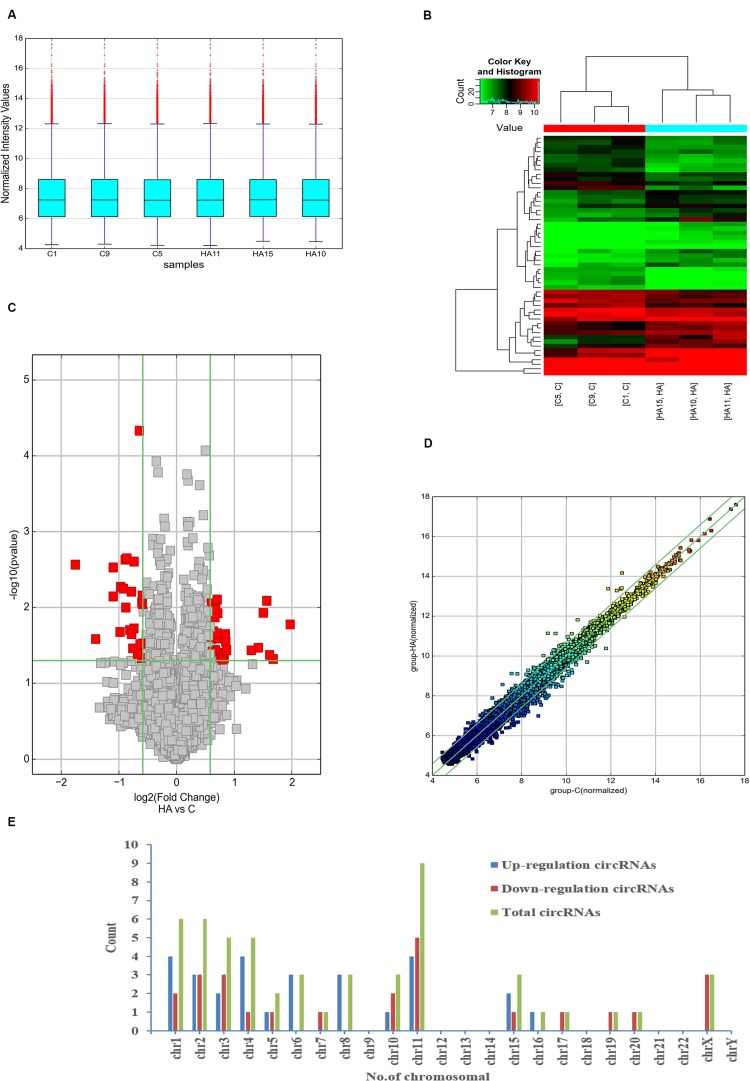
Differential expression of circRNAs in rat hypothalamus. (A) Box plot showing the distribution of circRNA expression values in the HA and C groups. (B) Hierarchical clustering of circRNAs differentially expressed between the hypothalamus of rats in the HA and C groups; each group contained three individuals (>1.5-fold difference in expression; P < 0.05). Expression levels above and below the median expression level were indicated with different colors in all samples. (C) Volcano plots constructed using the fold changes (FCs) and P-values are shown. Vertical lines correspond to 1.5-FC in the up- and downregulation between the HA and C groups, and horizontal line indicates the P-value. The red dot in the figure indicates circRNAs with significant difference in expression. (D) Visual assessment of differences in circRNA expression between HA and C using scatter plots. The values corresponding to the x- and y-axes in the scatter plot are the normalized signals of the samples (Log2 scaled). Green lines indicate FCs. The circRNAs above the top green line and below the bottom green line show a >1.5-FCs between the HA and C groups. (E) Chromosomal distributions of differentially expressed circRNAs are shown.